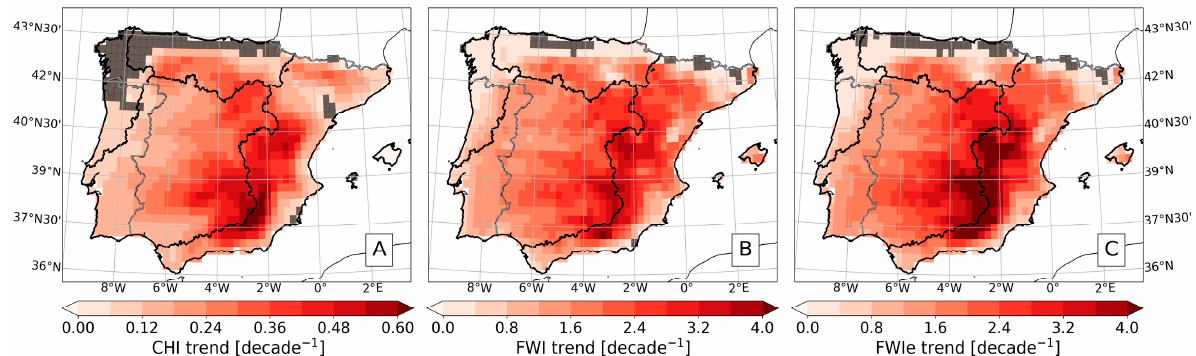
by the grey scale) and (2) by means of linear regressions (as shown by the colored lines) estimated for each FWI class (shown as vertical black bars).